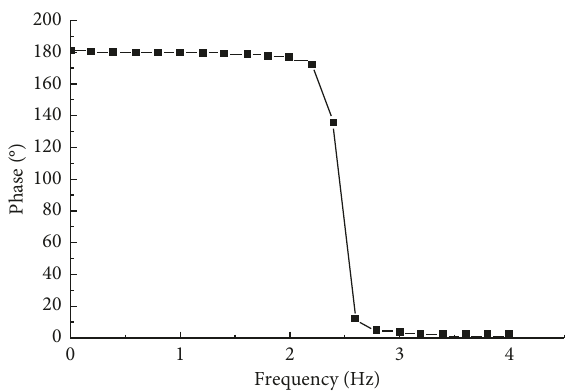
Figure 13: Buffering device phase-frequency curve.